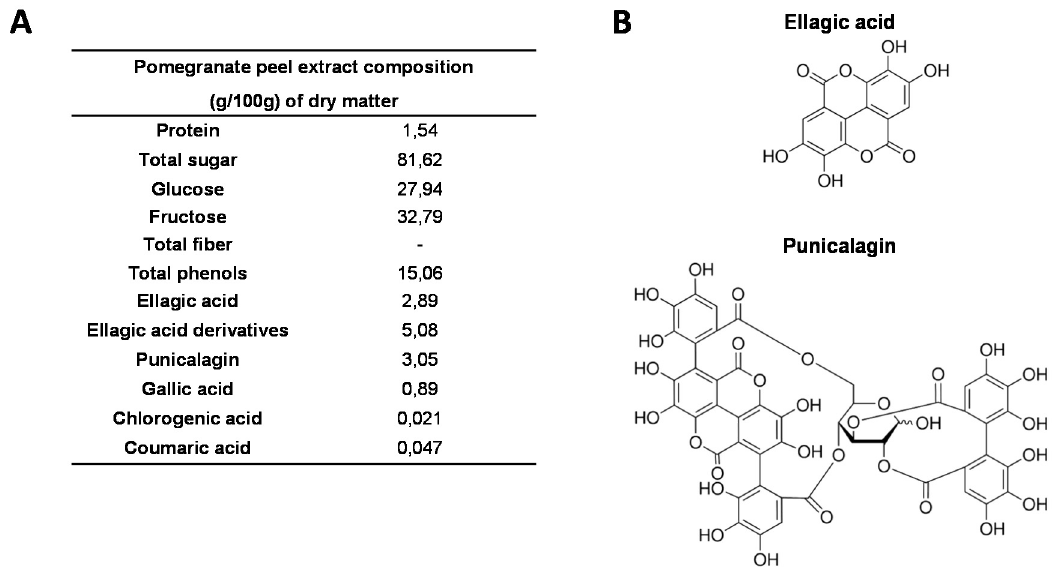
Figure 1. Composition of pomegranate peel extract (PGPE). ( A ) Chemical composition of PGPE (g/100 g·dry·matter). ( B ) Chemical structure of ellagic acid and punicalagin, the two major polyphenolic compounds of PGPE.